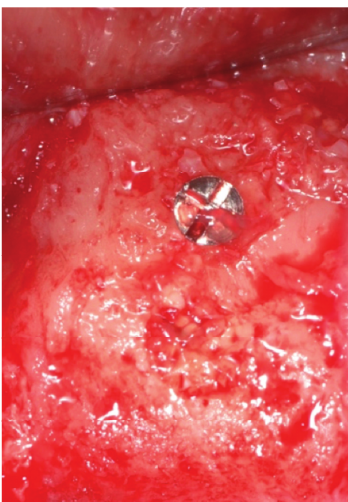
Figure 10: Clinical view of the bone block during the reentry procedure. The graft is completely integrated with the surrounding bone, with no volumetric resorption as demonstrated by the bone levels circumferentially around the transcortical screw.